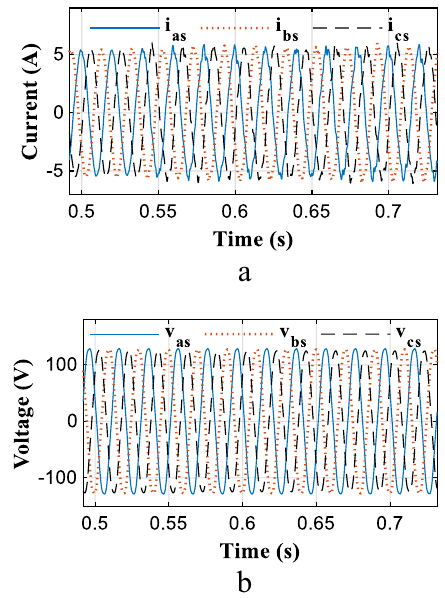
Fig. 22 The accurate working values of CT and PT. a Three-phase stator currents, b Three-phase stator